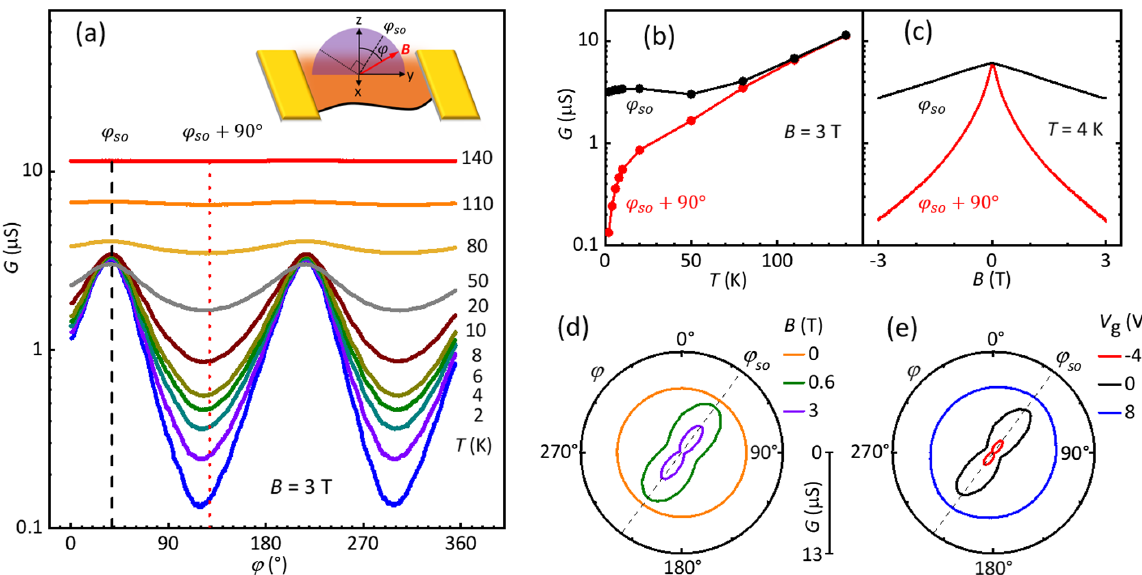
FIG. 3. Dependence of the anisotropy on temperature, field strength, and gate voltage. (All measurements are for contacts 1 and 2 in device MW5.) (a) Two-terminal conductance measured while rotating B in the y - z plane (see the sketch above), at a series of ¼ − 2 . 7 V). (b) Corresponding temperature dependence of G at fixed field orientations φ ¼ φ temperatures ( B ¼ 3 T and V g φ ¼ φ þ 90 °. (c) Effect of sweeping the field at T ¼ 4 K for the same two orientations. (d) Polar plots of G versus φ for different so ¼ − 2 . 7 V and T ¼ 4 K). (e) Similar plots for different V field strengths ( V g divided by